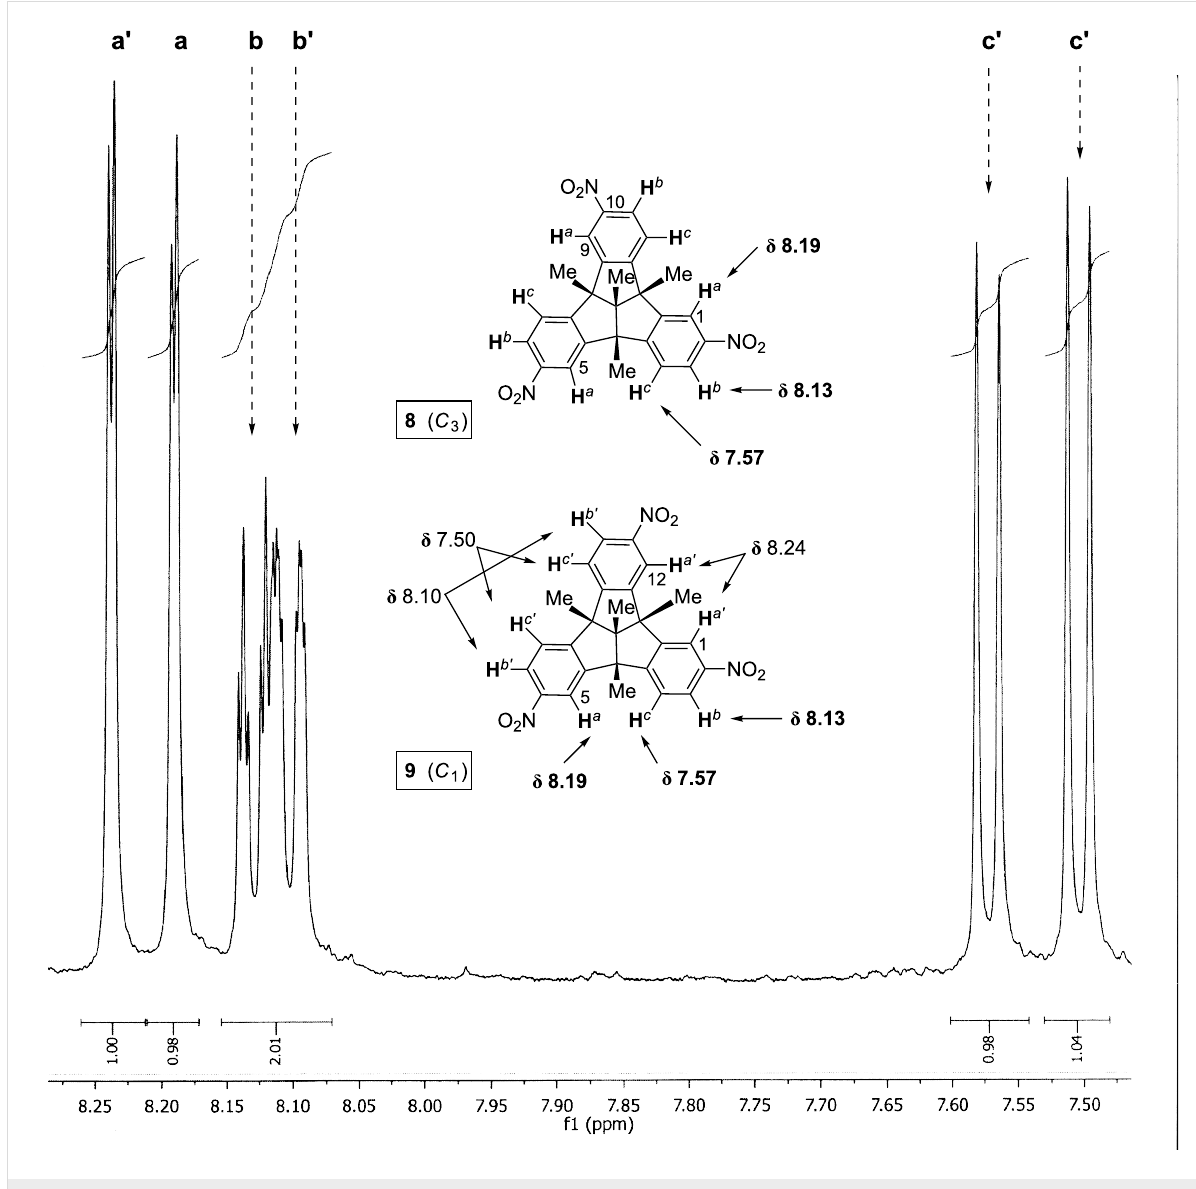
Figure 2: Partial 1 H NMR spectrum (500 MHz, CDCl 3 ) of the mixture of the trinitro-TBTQ isomers 8 and 9 .